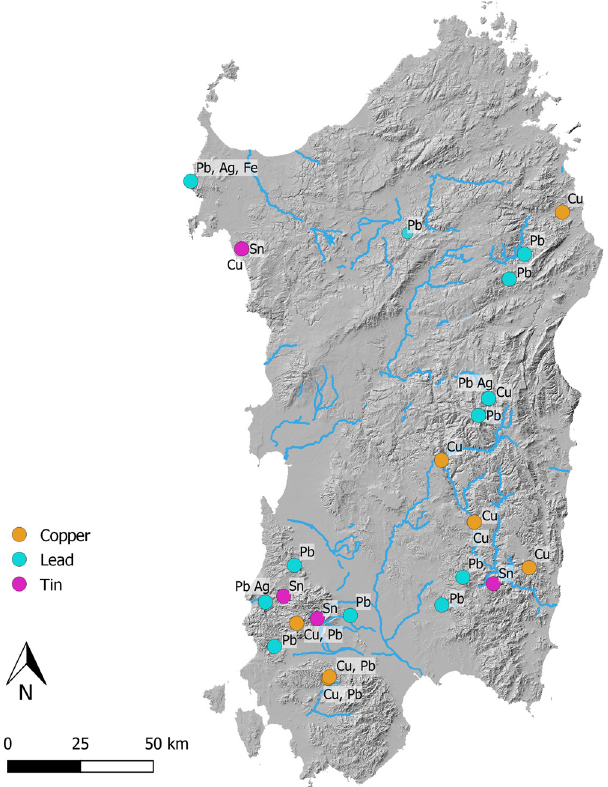
Figure 3: Sardinian mineral deposits possibly exploited during the Bronze and Iron Ages. The majority of the copper ( Cu ) and lead - silver ( Pb, Ag ) ores are located in the southwest of the island, in the so - called “ metalliferous ring ” ( Iglesiente, Sulcis, Arburese, Fluminese ) . Important copper and lead - silver deposits were also located in the northwest ( Argentiera and Calabona ores ) and in the center of the island ( Funtana Raminosa and Barbagia ) . Data source: Valera et al., 2005a, map: V. Matta